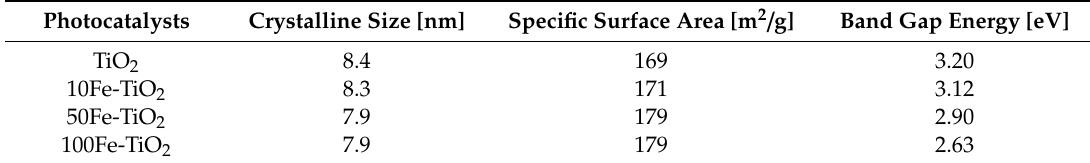
Table 1. List of the prepared photocatalyst and their characteristics.